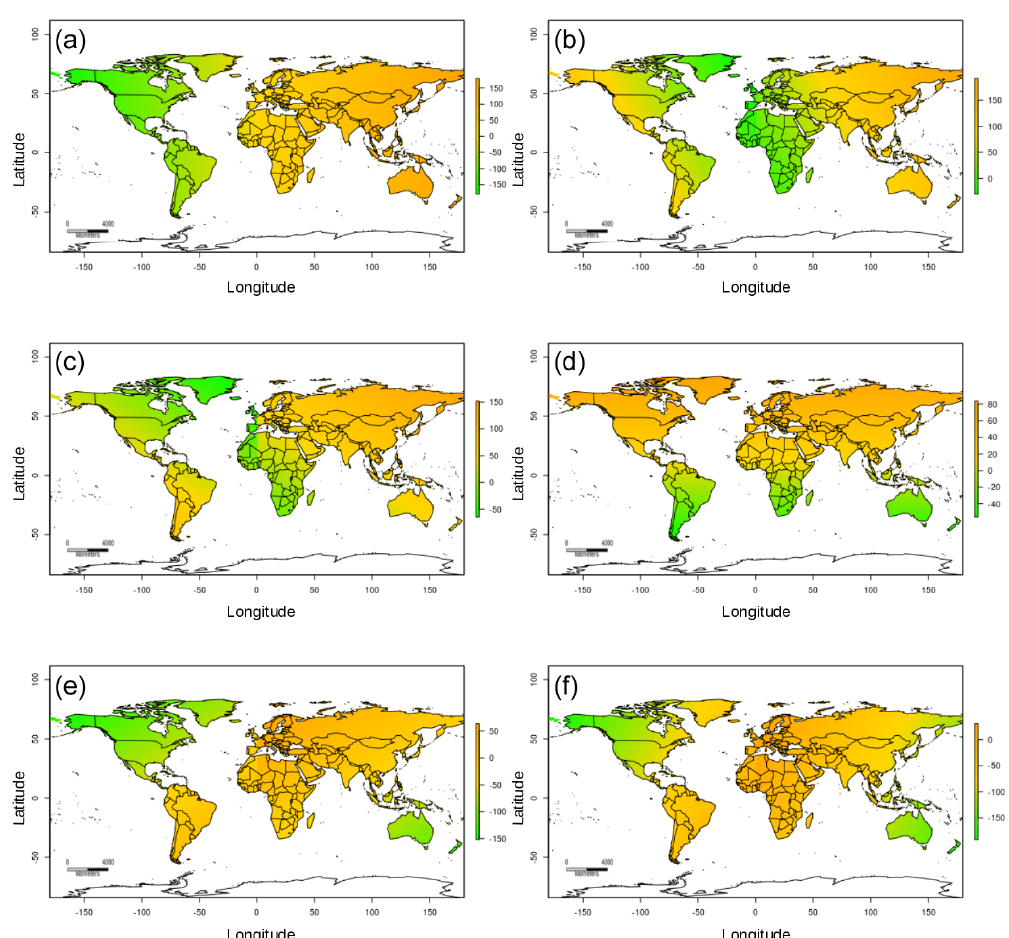
Figure A2. The variables pi0.00 (a) , pi0.17 (b) , pi0.33 (c) , pi0.50 (d) , pi0.67 (e) , and pi0.83 (f) are spatial coordinates of the global 15km grids tilted at multiple angles ( n = 6) used as ancillary information in order to explicitly account for the spatial structure of available soil moisture values in the geographical